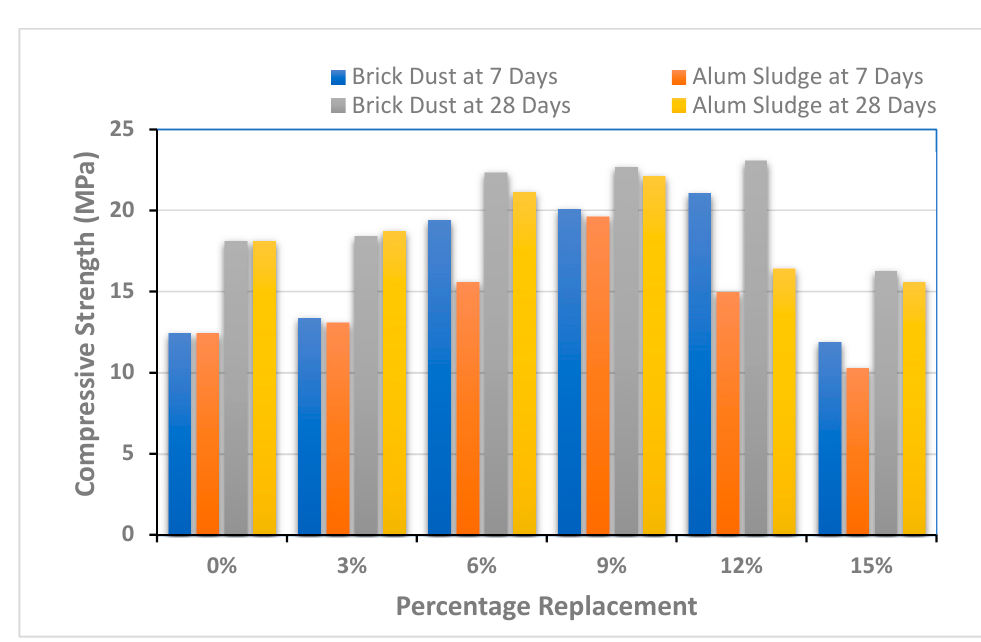
Figure 5. Compressive strength performance of composite material.